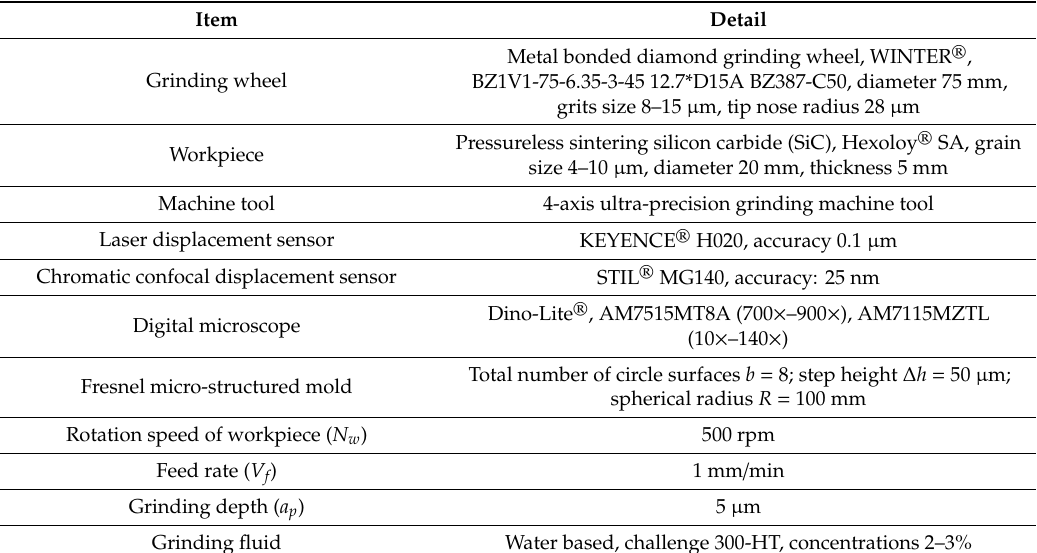
Figure 9. The grinding experiment system for the Fresnel micro-structured mold: ( a ) the grinding experiment devices; ( b ) the copied profile of the edge tip of the grinding wheel; ( c ) the measurement result of the radial run-out error of the grinding wheel. Table 1. Grinding experiment conditions.